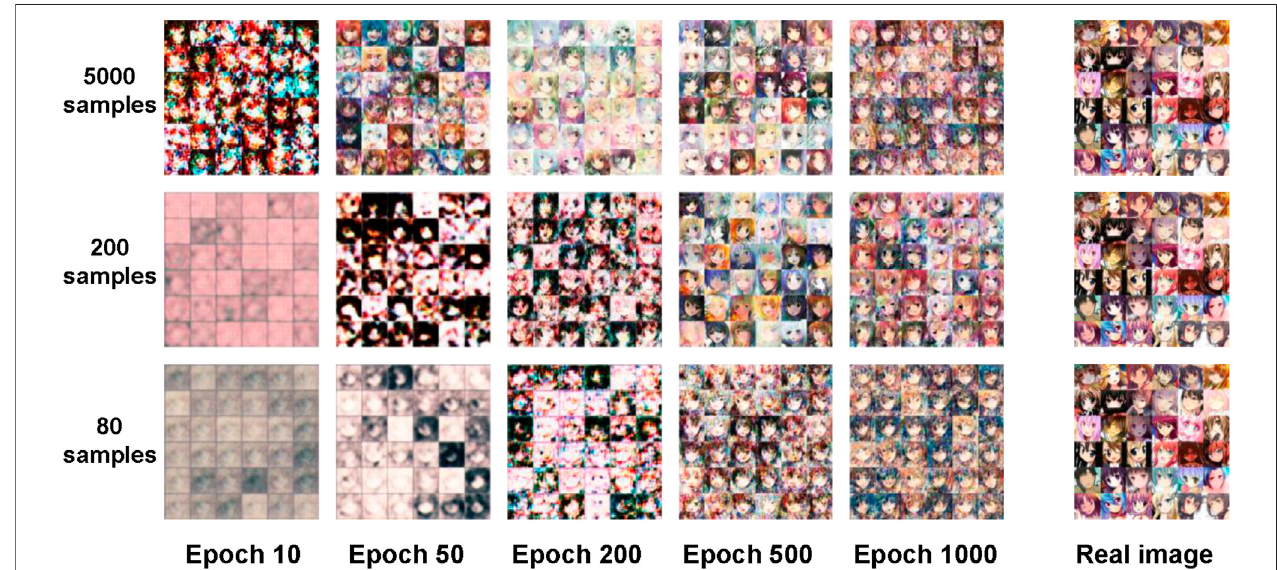
FIGURE 4 | The fi rst, second, and third rows show the synthetic images with sample numbers of 5000, 200, and 80, respectively. The fi rst fi ve columns show the synthetic images at different epochs. The last column shows the real images.